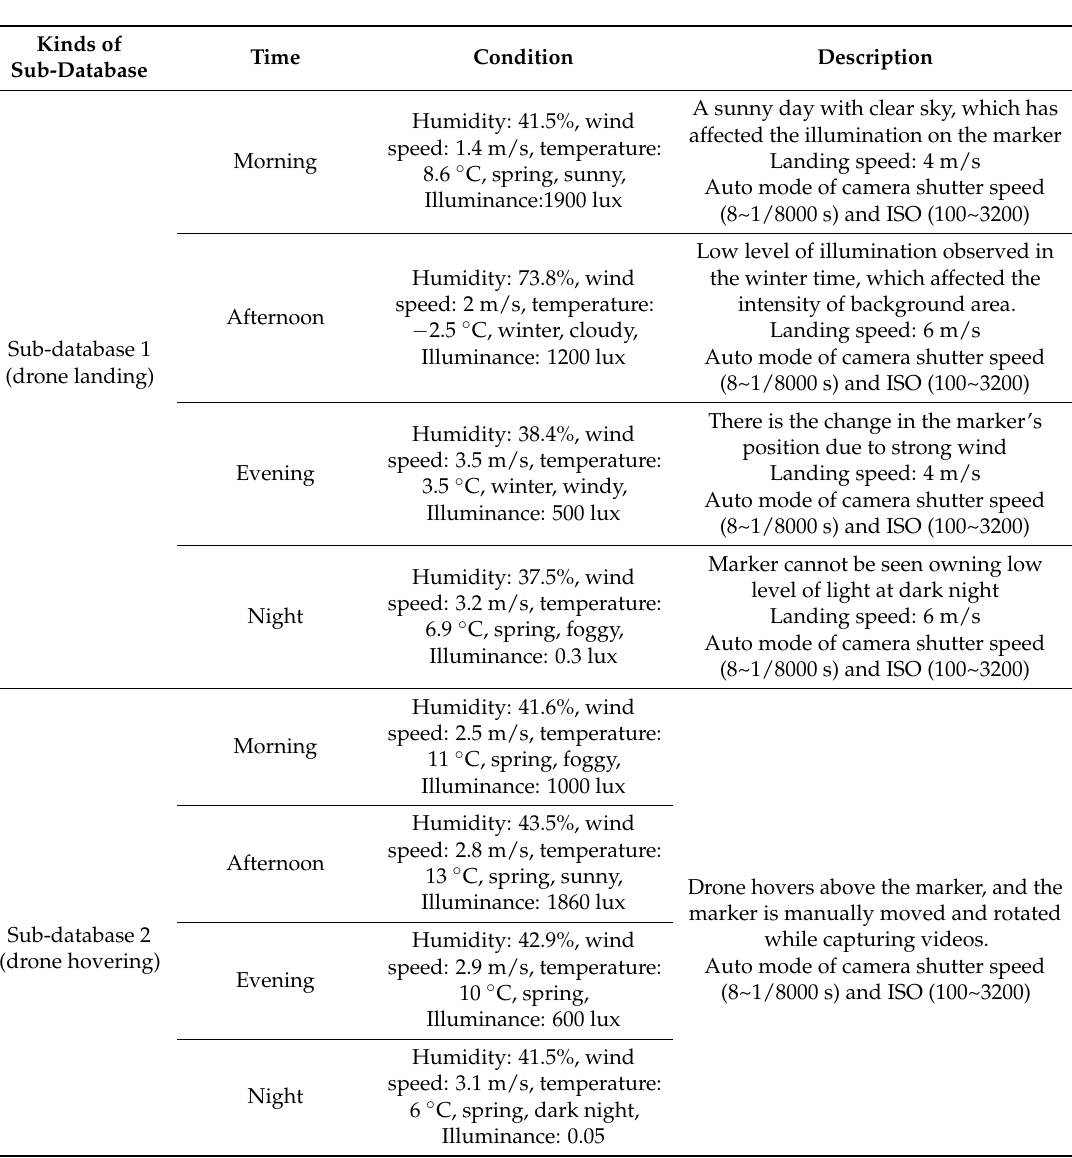
Table 2. Description of